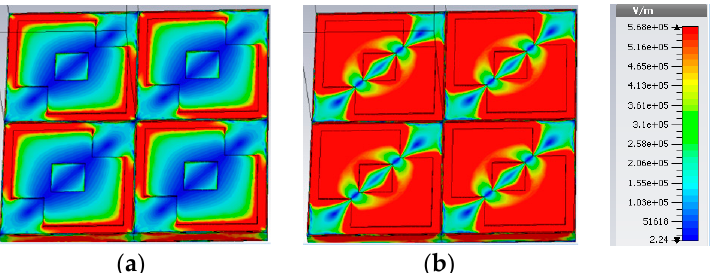
Figure 8. Electric field distribution considering the four cells of the metasurface array at: ( a ) 1.085 THz; ( b ) 1.454 THz.